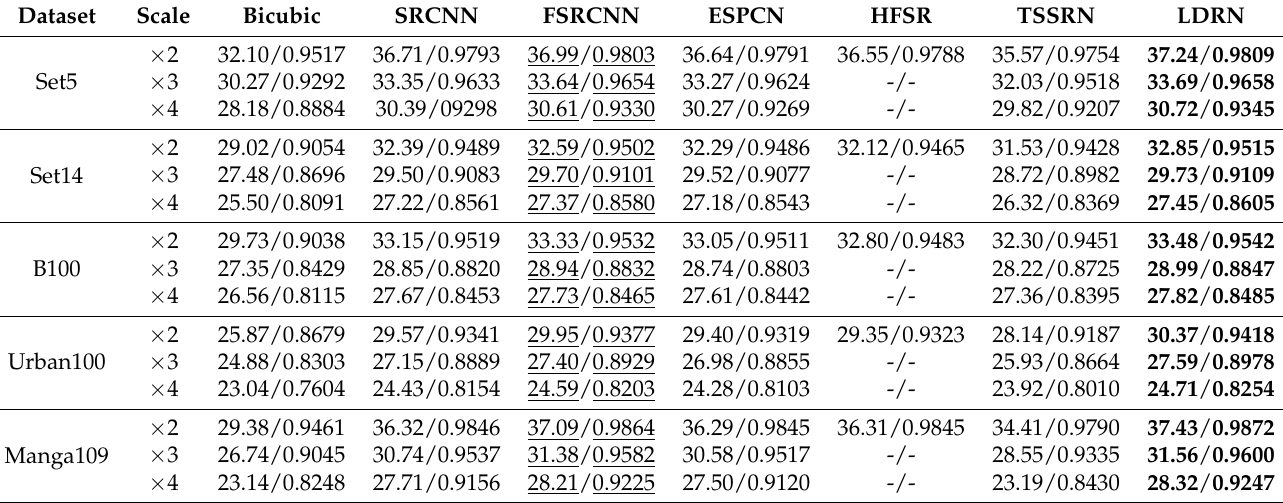
Table 4. The results of PSNR and SSIM on public benchmark datasets (Gaussian). Bold indicates the best performance, while Underline indicates the second best.